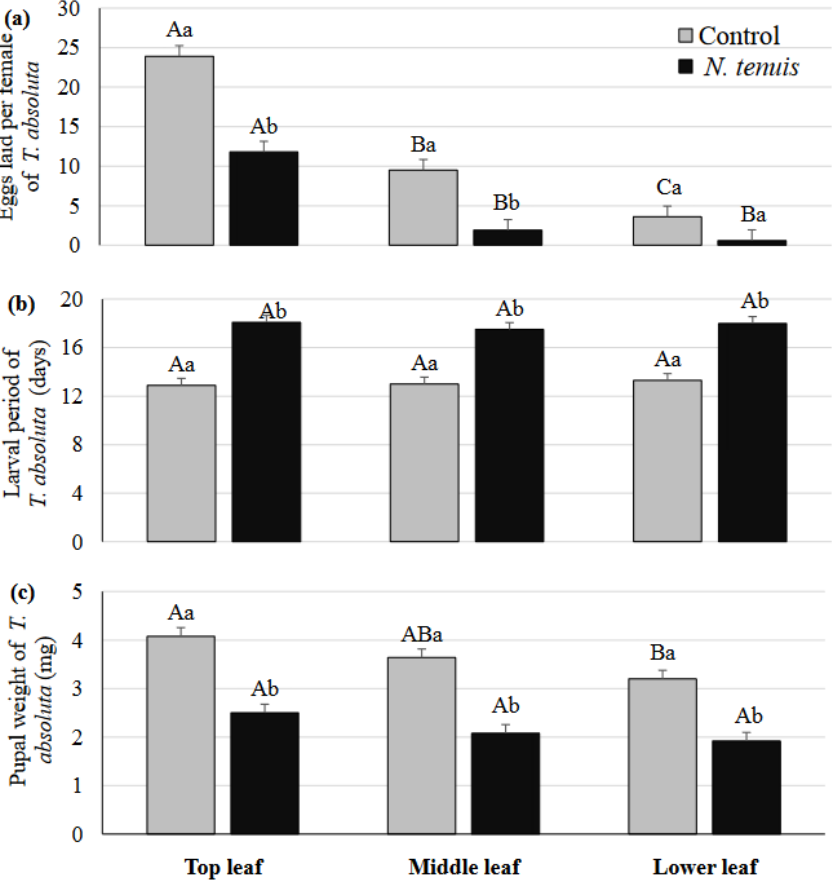
Figure 1. Number (mean ± SE) of eggs oviposited ( a ), larval period, ( b ) and pupal weight ( c ) of T. absoluta on top, middle, and lower leaves of tomato plants punctured by N. tenuis , in comparison to unpunctured (control) tomato plants. Columns with the same capital letter are not significantly different among leaves within each treatment, and columns followed by the same small letter are not significantly different between treatments within each leaf category (ANOVA, Tukey HSD, p < 0.05, n = 10).